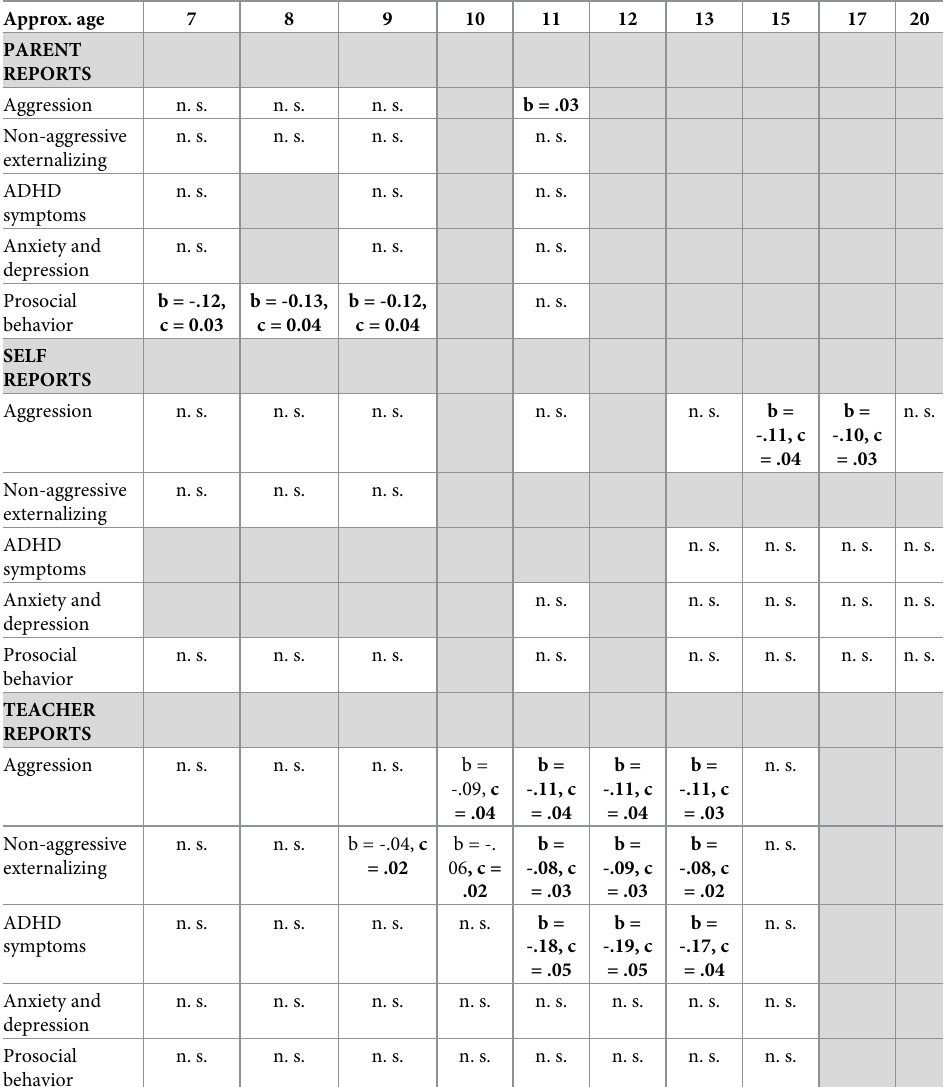
Table 2. Amount of time in care by daycare mothers and social behavior by age. Unstandardized coefficients from growth curve